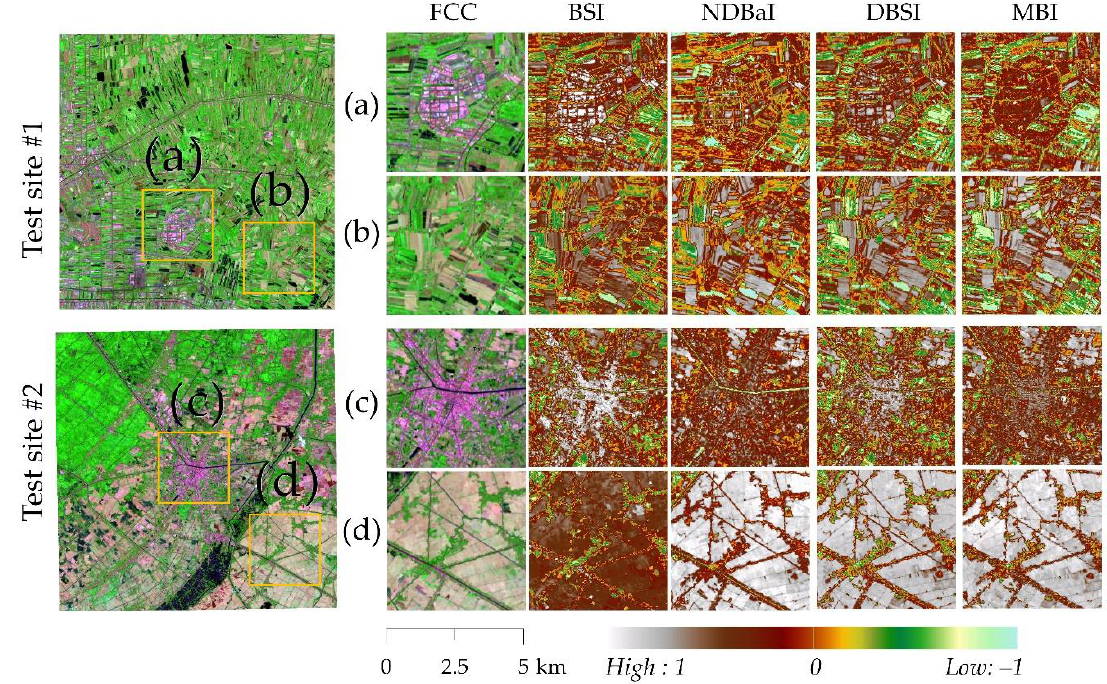
Figure 5. False-color composite (RGB: 7-5-3) on entire test sites and zoom-in regions in typical urban and bare land areas describing distinguishability between bare soil and other land cover types on different indices: ( a , c ) DBSI, ( b , d ) NDBaI and MBI.